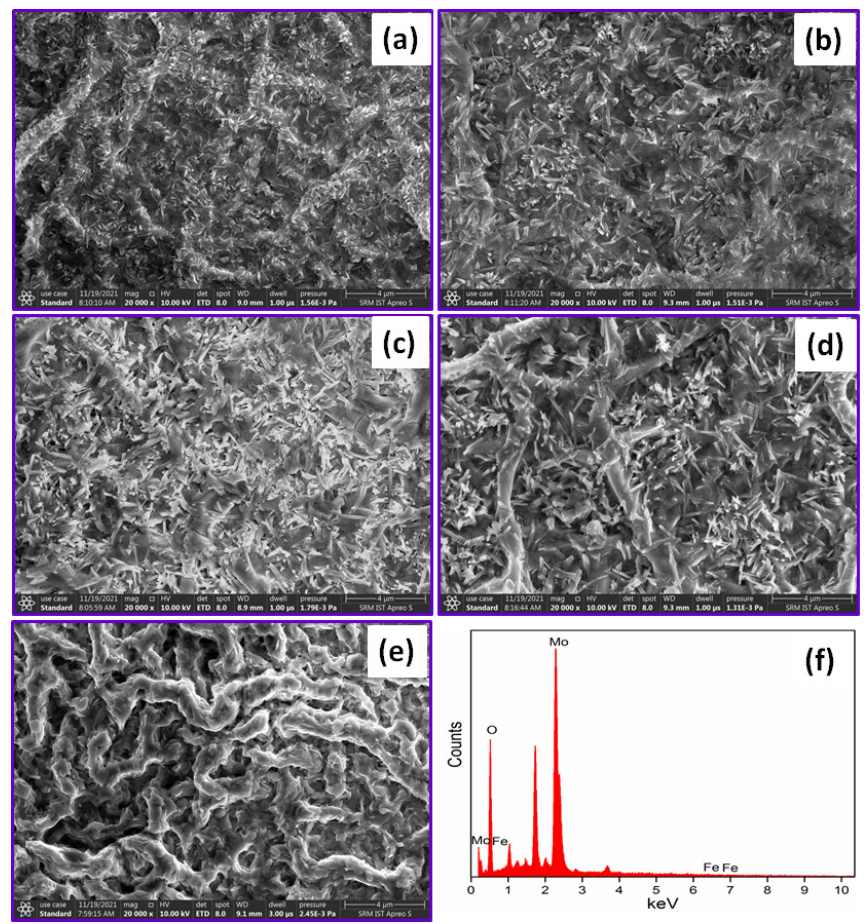
Figure 2. FESEM images of Fe doped MoO 3 thin films ( a ) 0%, ( b ) 1%, ( c ) 2%, ( d ) 3%, ( e ) 4% of Fe and (f) EDX image of MoO 3 :Fe(3%) thin film. Figure 3 represents the transmission spectra of MoO 3 :Fe (0, 1, 2, 3 and 4%) thin films observed within the wavelength range 300–900 nm. It has been noticed that the transpar- ency of films increases with the increase of dopant concentration and reaches maximum transparency for MoO 3 :Fe(3%) due to the enlarged voids generated in the thin films, which can be identified through the SEM image. This is ascribed to the structural defor- mations occurred by the amalgamation of Fe 2+ ions which substitutes the Mo 6+ ions from the host MoO 3 matrix [38]. The diminution in transmittance for Fe dopants (1, 2, and 4%) are due to the amplified scattering of photons originated by the crystal defects, where the voids are less compared to the Fe(3%) dopant concentration [39,40].